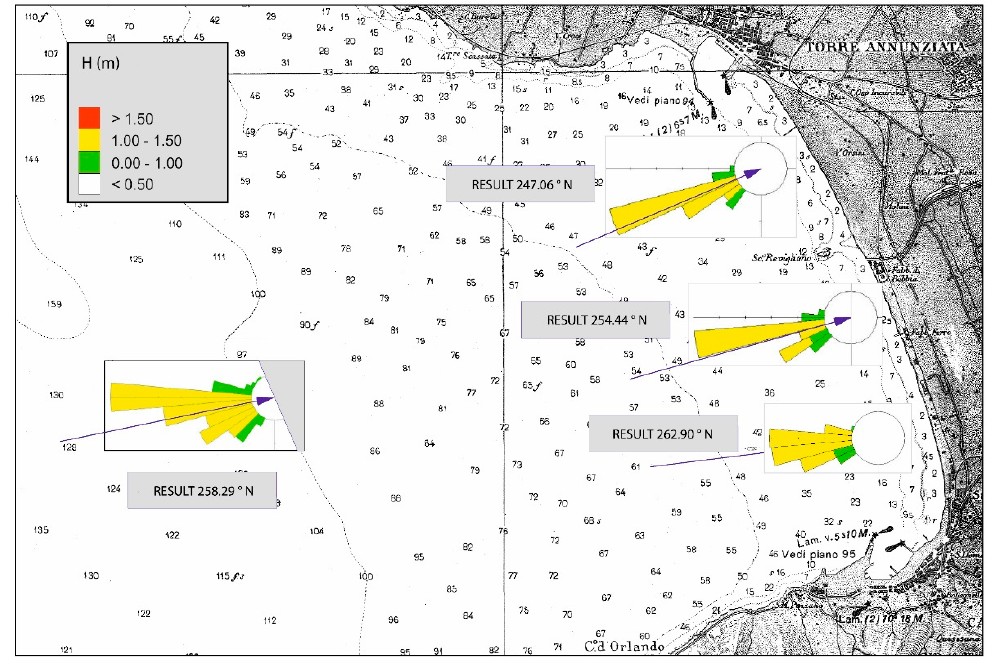
Figure 14. Results of hydrodynamics and wave patterns (from [25]).